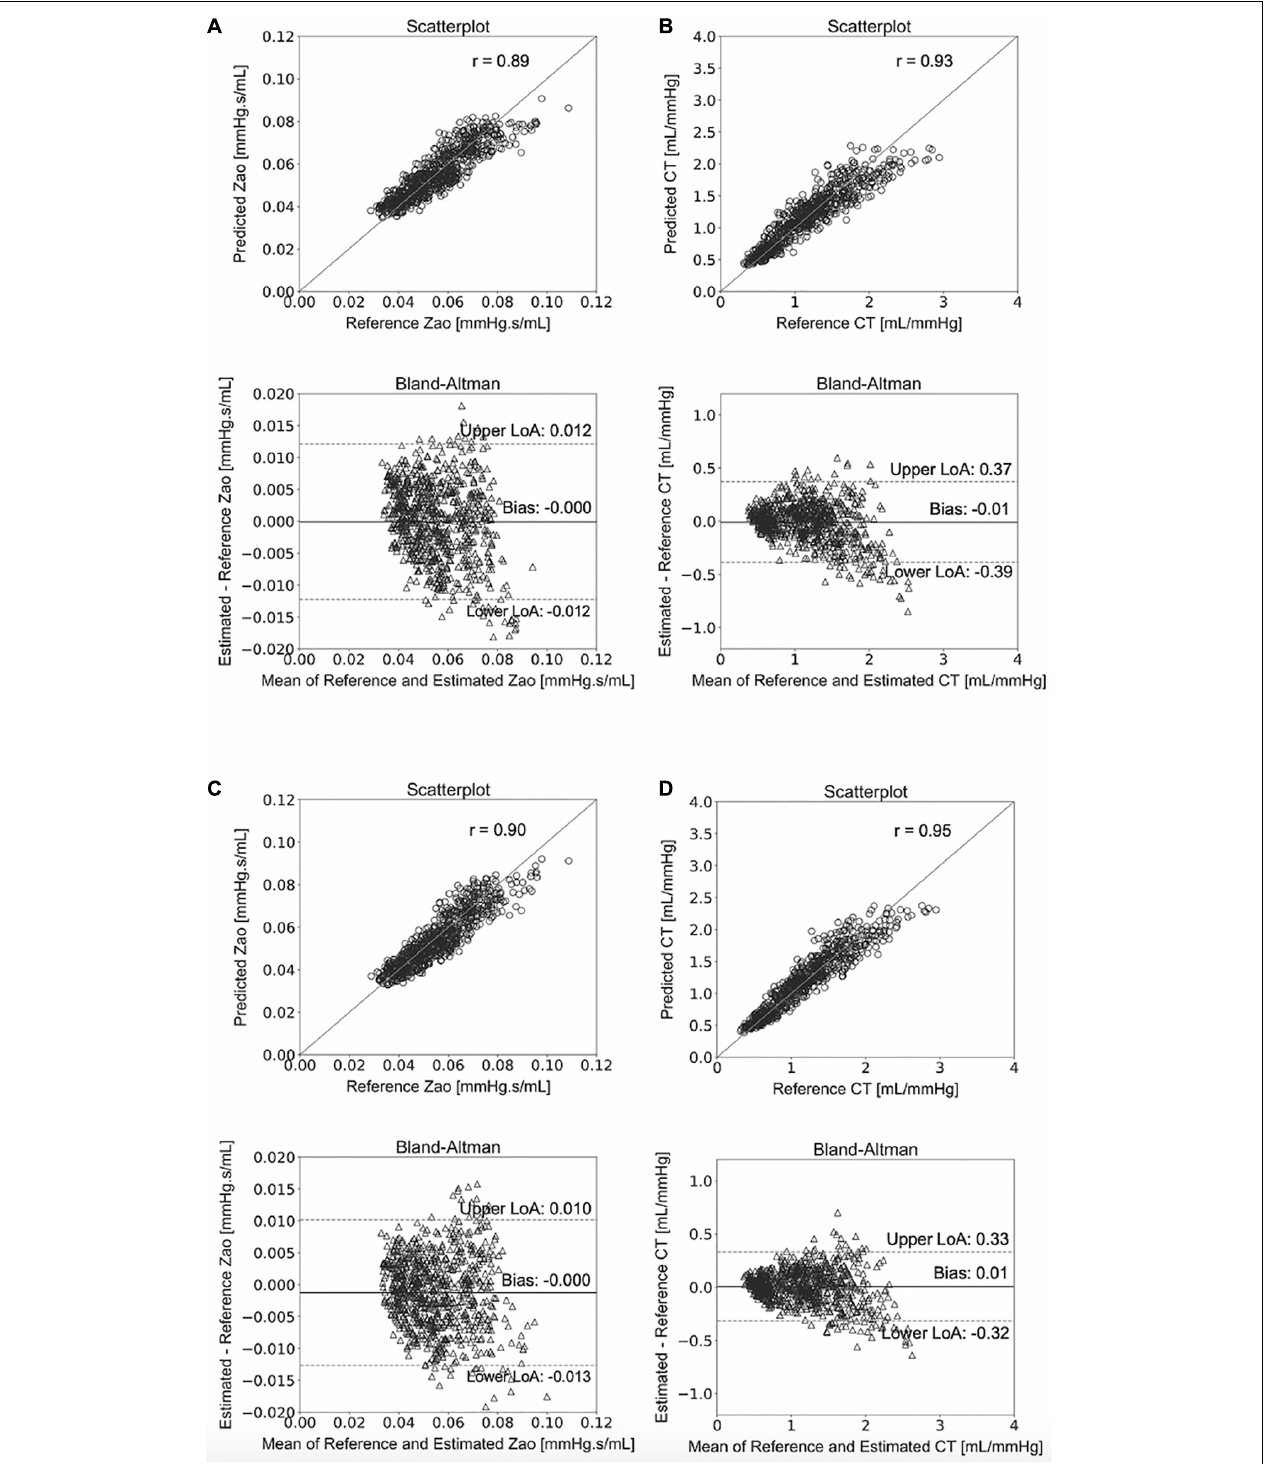
FIGURE 6 | Comparison between predicted and reference data. Scatterplots and Bland–Altman plots between: the predicted Z ao and the reference Z ao using the RFR (A) and the ANN (C) , respectively, and the predicted C T and the reference C T using the RFR (B) and the ANN (D) , respectively. The solid line of the scatterplots represents equality. In Bland–Altman plots, limits of agreement (LoA) are defined by the two horizontal dashed lines.